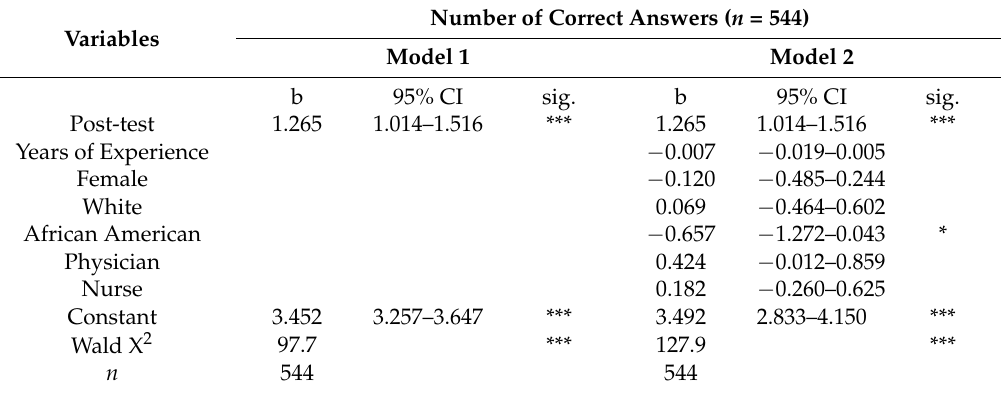
Table 3. Random Effects Regression Models for Knowledge Quiz